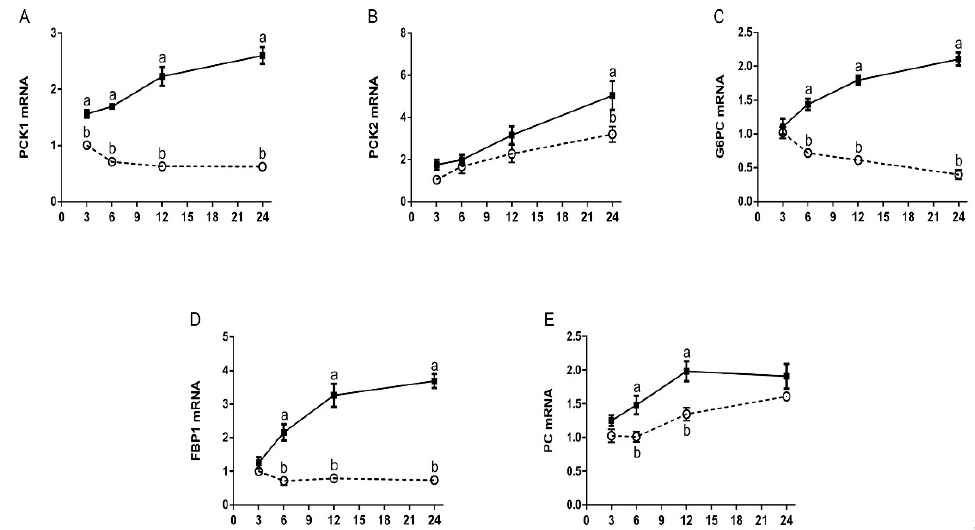
Table 2. The expression of genes involved in the gluconeogenesis pathway in bovine hepatocytes incubated with 0 (control), 0.15, 0.6, and 1.2 mM His in vitro. ( n = 6). Figure 2. Effects of His on the mRNA levels of key genes involved in gluconeogenesis pathway. Bovine hepatocytes were exposed to either 0 (dotted line, open circle) or 1.2 mM His (solid line, solid square) for the interval indicated time and harvested for mRNA level analysis. qRT-PCR analysis of ( A ) mitochondrial phosphoenolpyruvate carboxykinase 1 (PCK1), ( B ) mitochondrial phosphoenolpyruvate carboxykinase 2 (PCK2), ( C ) glucose-6-phosphatase (G6PC), ( D ) fructose- 1,6-bisphosphatase 1 (FBP1), and ( E ) pyruvate carboxylase (PC) in bovine hepatocytes. GAPDH was used as an internal reference gene. Data shown are means ± SEM of six independent experiments. Different lowercase letters indicate significant differences.